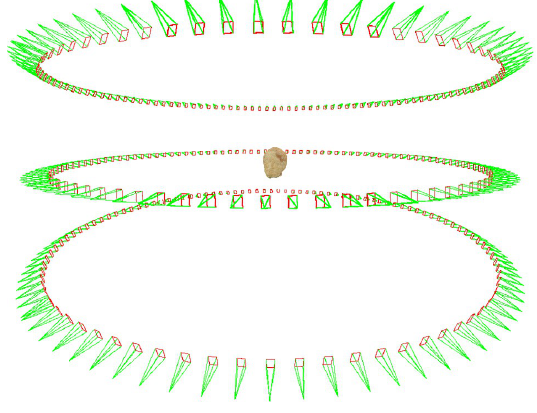
Figure 5: Orientation